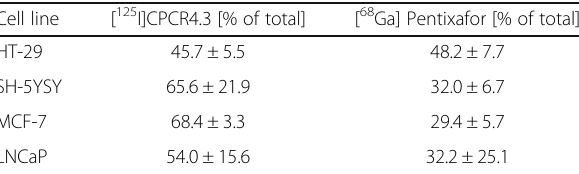
Table 2 Internalization efficiency (internalized activity in % of total cellular activity) of [ 125 I]CPCR4.3 (0.1 nM) and the reference [ 68 Ga] Pentixafor (1 nM) in different human cancer cell lines after 60 min at 37 °C. Data are corrected for non-specific binding/internalization in the presence of 100 μ M AMD3100. Each experiment was performed in triplicate, and results are means ± SD Cell